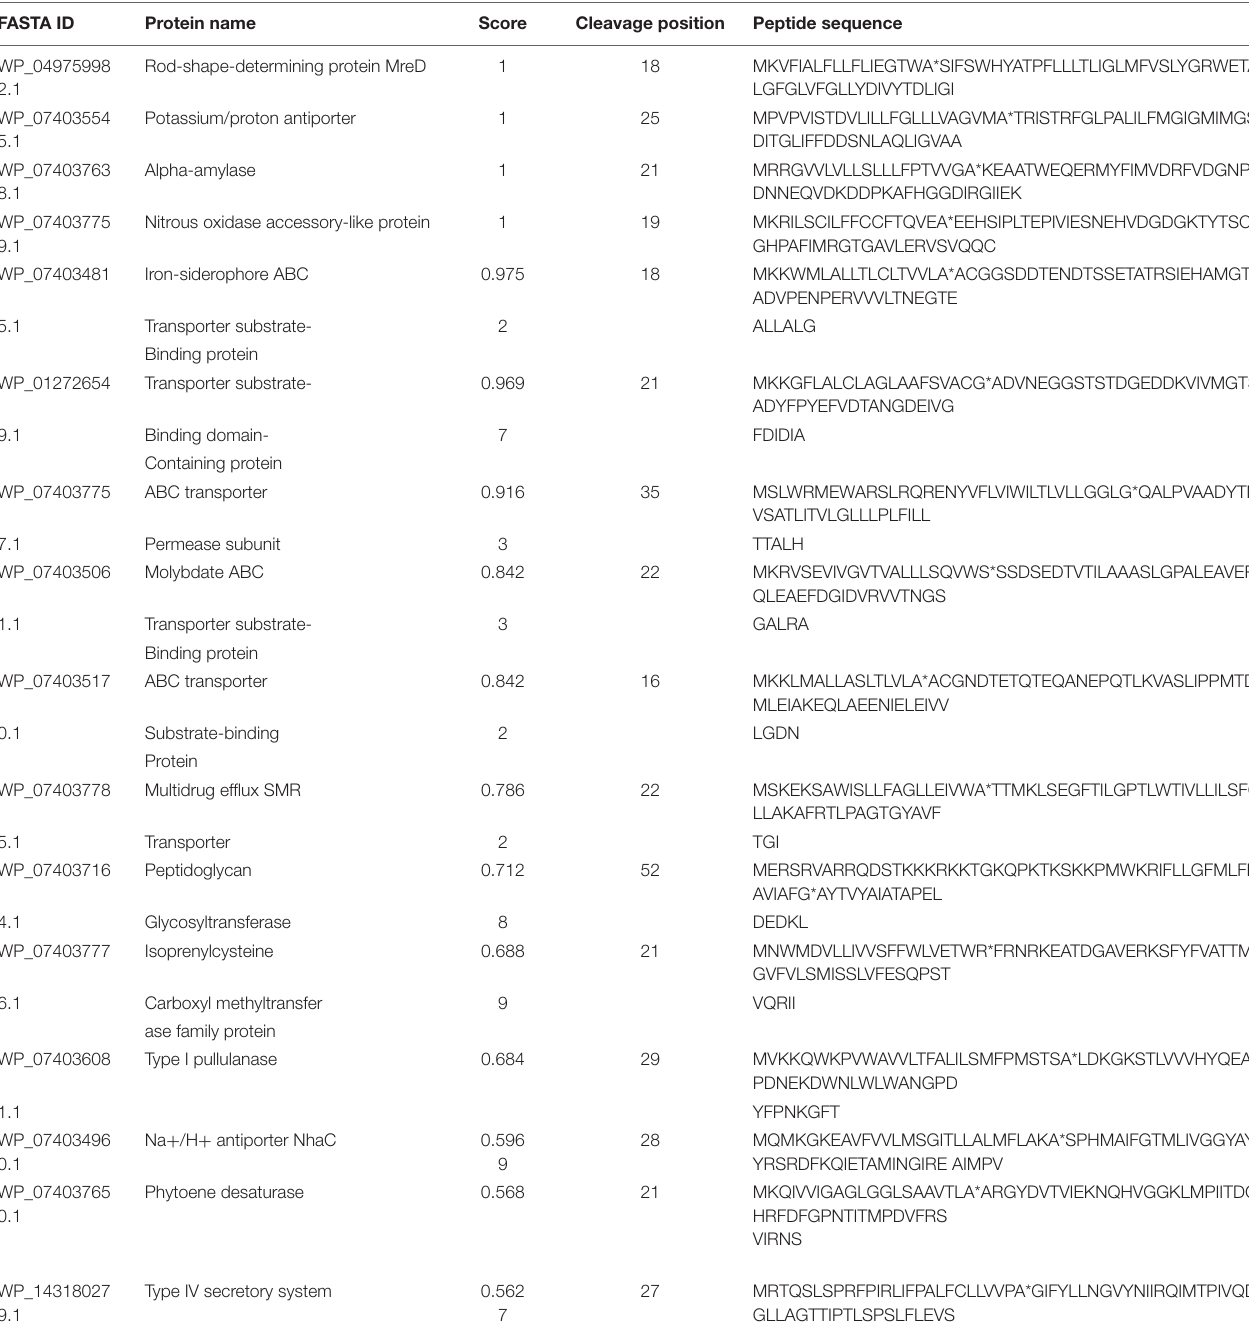
TABLE 5 | List of proteins with signal peptide prediction using PrediSi. FASTA